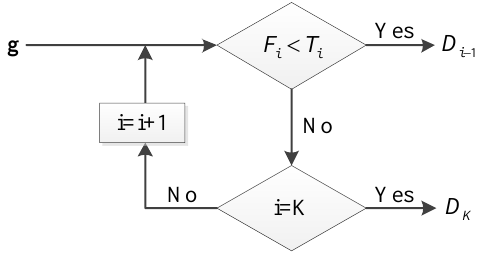
Figure 3. Diagram of the